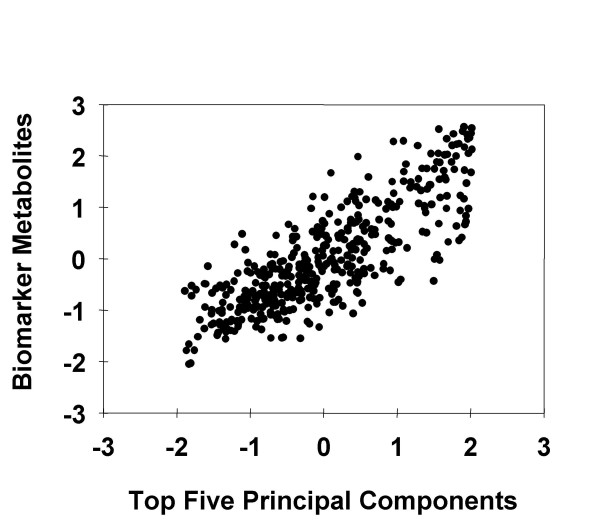
Plot of correlations among samples based on biomarker metabolites vs. based on principal component scores. The biomarker metabolite set does a reasonable job of mimicking the pattern among the sampled tissues based on the top five principal components. The pattern among the tissues with respect to their metabolite composition is discerned by the set of all pairwise Pearson correlation values among the tissues. This "correlation measure" of the pattern among the tissues was applied using two different sets of markers. The set represented by the horizontal axis used the scores of the top five principal components from the analysis of the comprehensive metabolomics dataset. The set represented by the vertical axis used the biomarker metabolite concentrations. These metabolite concentrations are standardized and centered because our study was mainly interested in the magnitude and pattern of the variation in the metabolites during development. The correlation values plotted in the figure have been transformed to a Z-scale to bring out the accuracy (slope of a fitted line would be near 1 with an intercept near 0) in the ability of the biomarker metabolite set to mimic the pattern among the tissues, and with reasonable precision (r = 0.82).